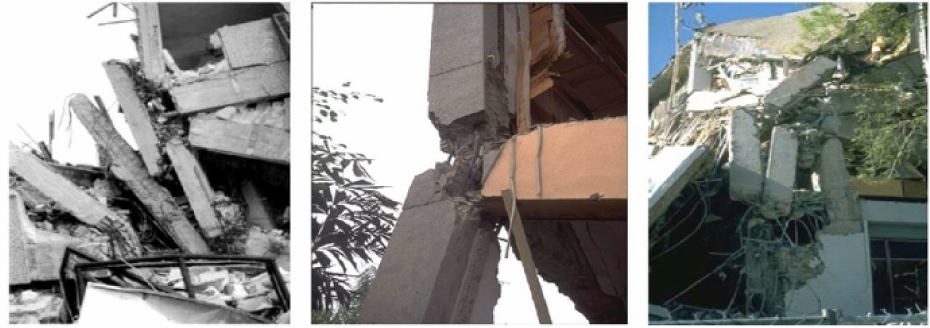
Figure 1. Partial collapse of buildings documented during large damaging earthquakes: from left to right: 1999 Izmit earthquake in Turkey, 1999 Chi-Chi earthquake in Taiwan, and 1994 Northridge earthquake in the